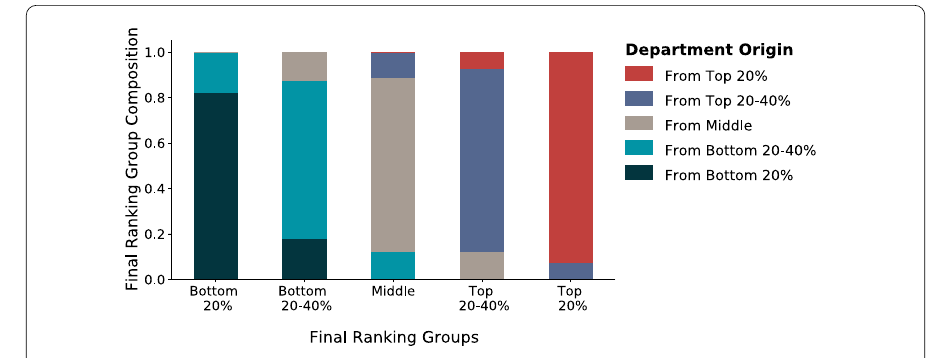
Figure 5 Final ranking group composition of Business departments. Rank mobility results derived from the best fitting Faculty production model with egalitarian initialization, with β = 1.0 and p = 0.007.